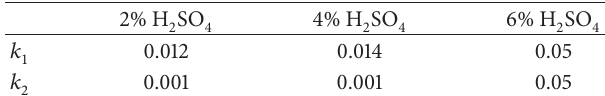
Table1: 𝑘 1 and 𝑘 2 valuescalculatedat120 ∘ Candacidconcentrations of 2%–6%.